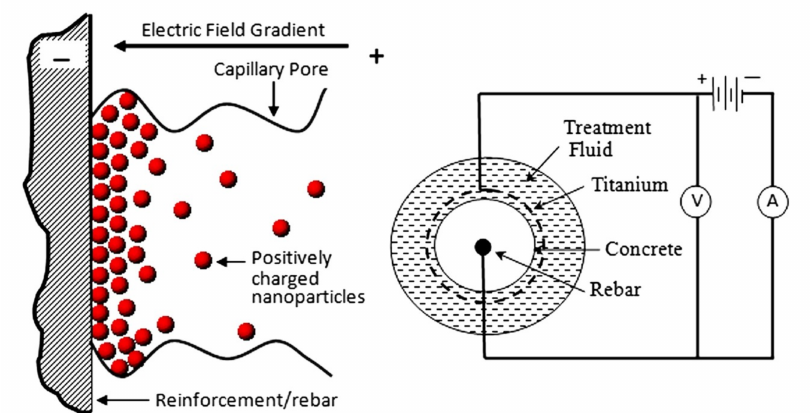
Figure 8. Concept of the nanoparticles transport into the capillary pores and the electrokinetic nanoparticles treatment circuit. Reproduced from [87], with permission from American Society of Civil Engineers,